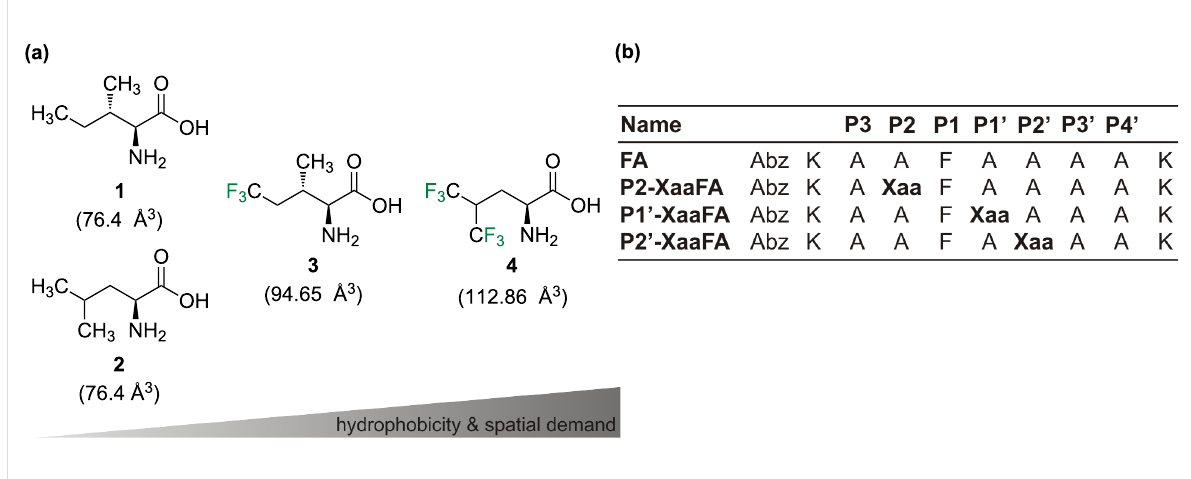
Figure 1: (a) Structures of isoleucine ( 1 ), leucine ( 2 ), and their fluorinated analogues 5,5,5 - trifluoroisoleucine ( 3 , TfIle) and 5,5,5,5’,5’,5’ - hexafluoro- leucine ( 4 , HfLeu). The van der Waals volumes given in parentheses correspond to the side chains (starting at α -carbon), and were calculated accord- ing to Zhao et al. [43]; (b) Names and amino acid sequences of the studied peptides; the substitution positions are marked as Xaa; Xaa = Leu, HfLeu, Ile or TfIle. Positions are named according to Schechter and Berger nomenclature [41].